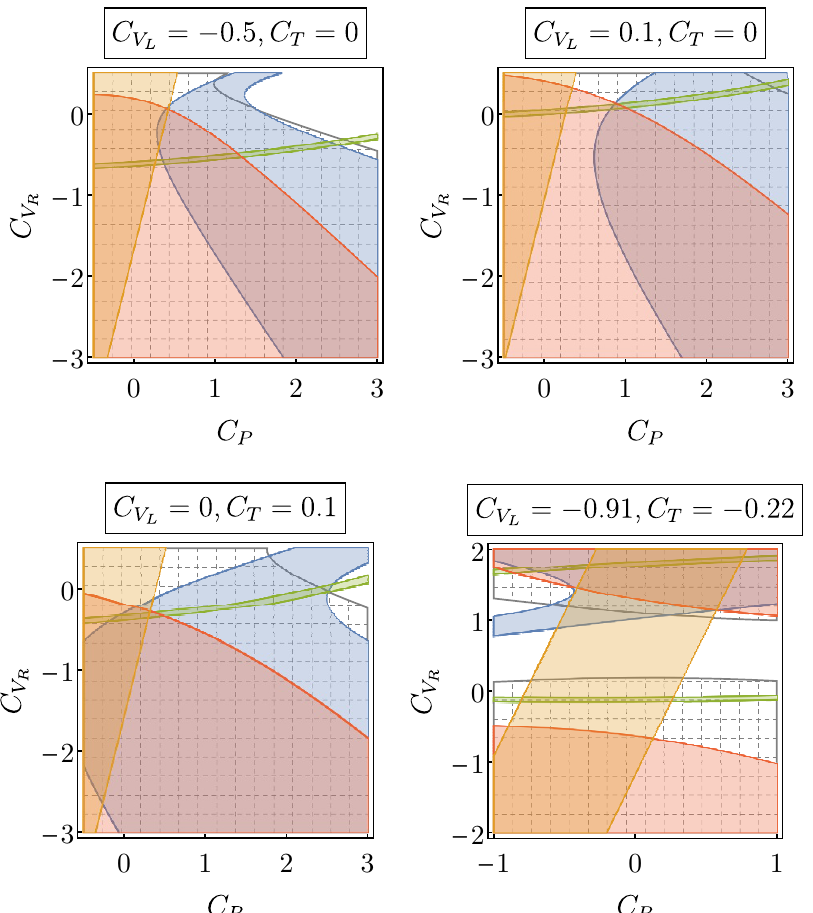
D (cid:3) (blue), (gray grid) and the q 2 (cid:3) (green), (cid:28) L R D P ( B c (cid:28) (cid:22) (cid:23) (cid:28) ) < B !